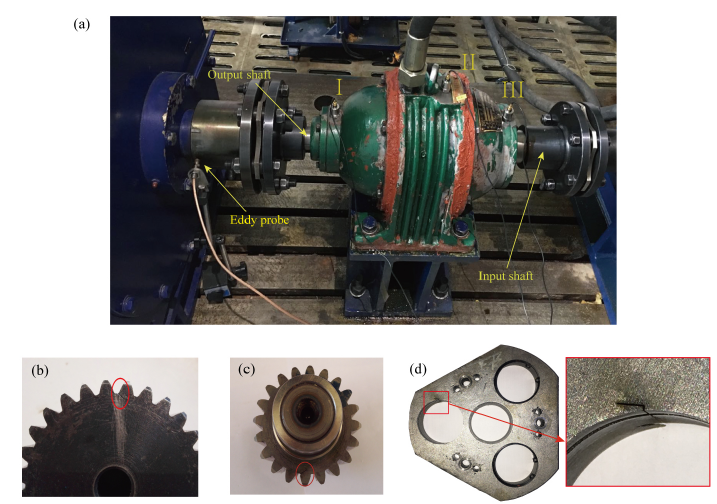
Figure 2. Experiment planetary gearbox: ( a ) test rig; ( b ) sun gear with tooth-root crack; ( c ) planet gear with tooth-root crack; ( d ) planetary carrier with crack.